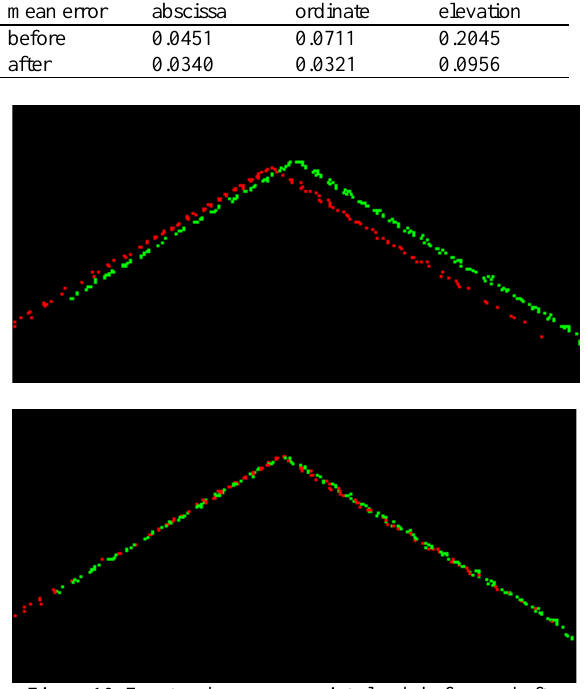
Figure 10. Front and rear cusp point clouds before and after